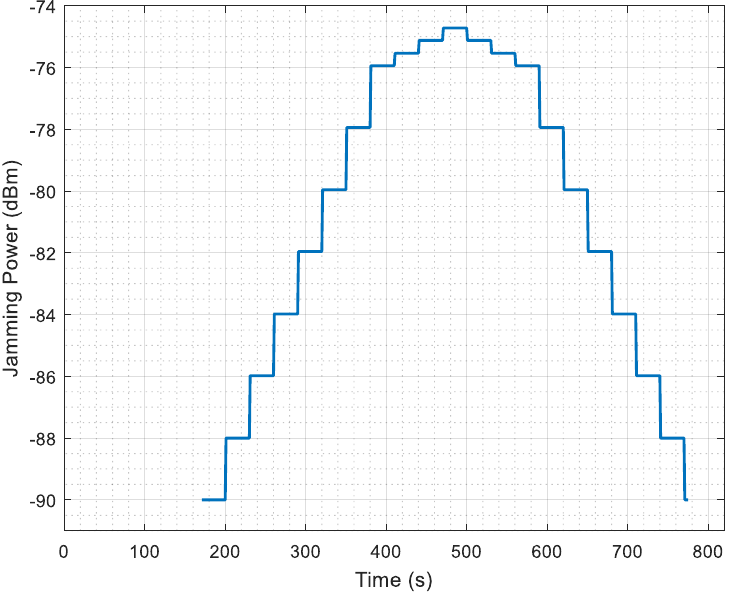
Figure 4. Sky-plot of the available satellites.